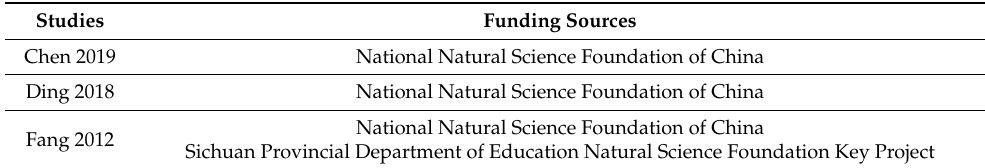
Table A16. Funding Sources of Included